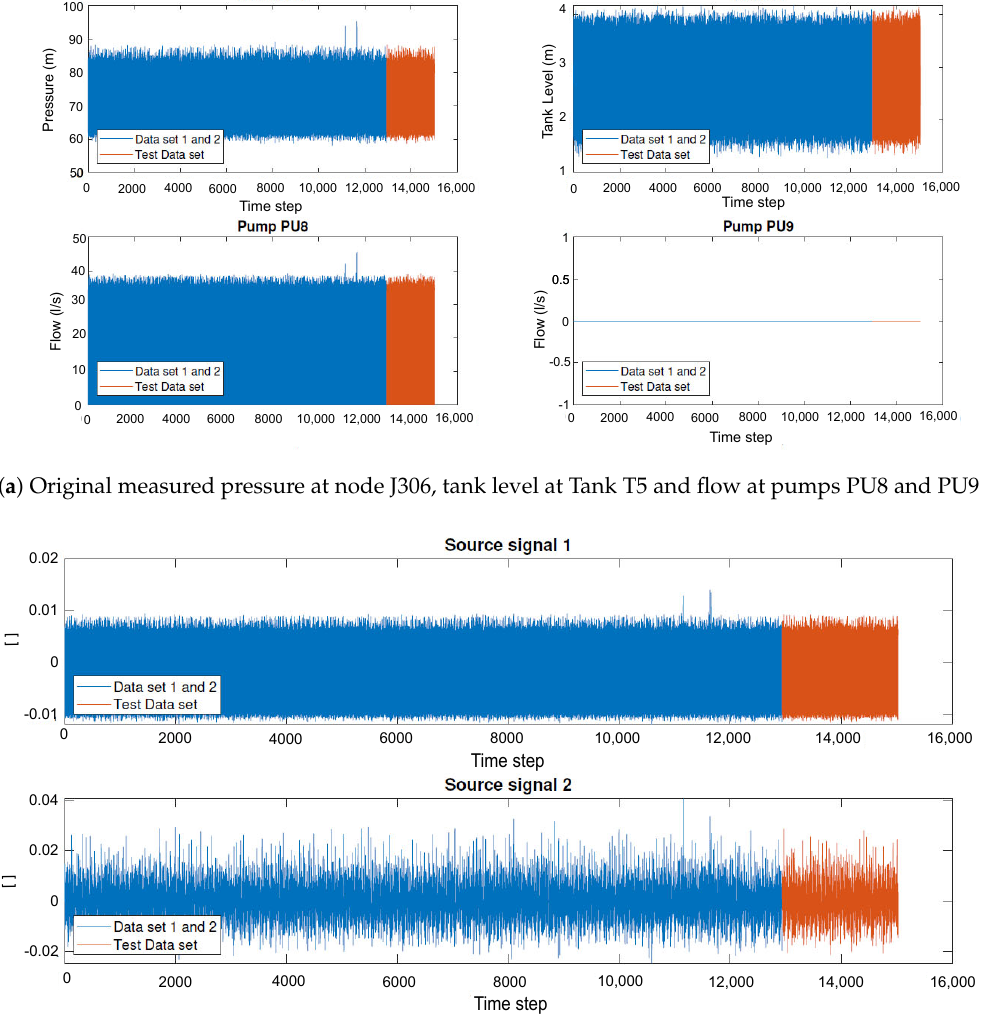
Figure 5. Original and processed data for combination